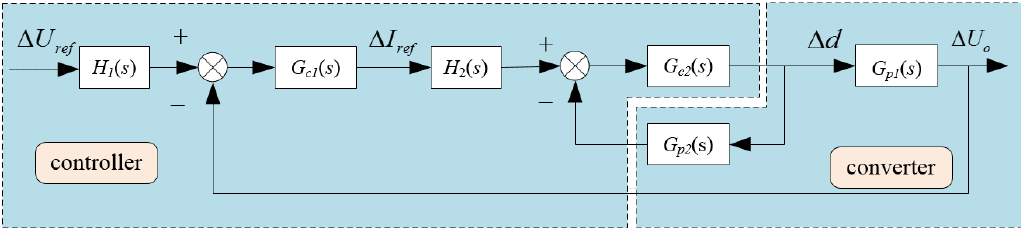
Figure 5. Bode diagram of Gp (s).